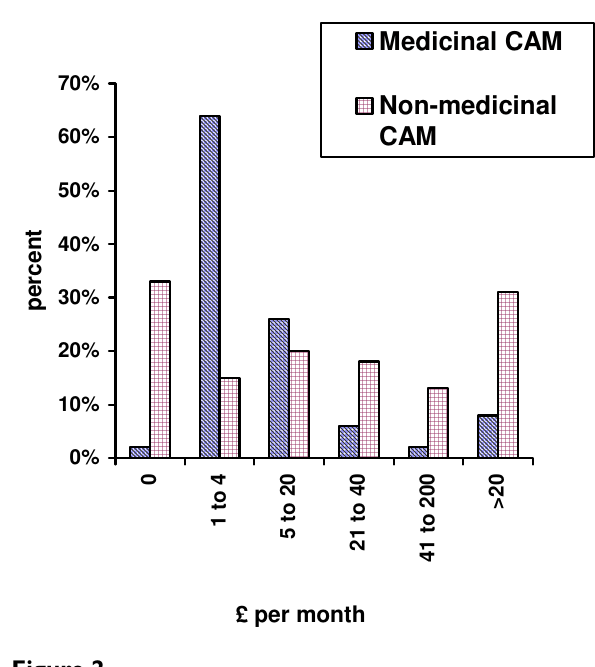
Expenditure on CAM (£ per